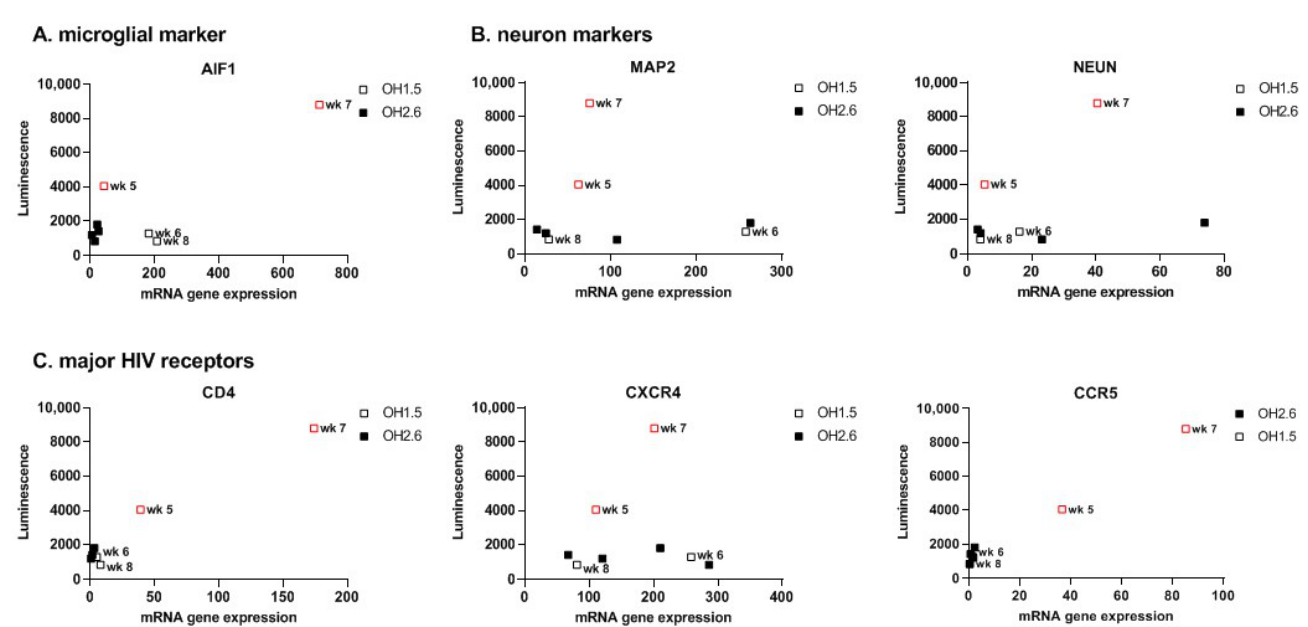
Figure 7. mRNA expression levels of microglia and neuron markers and HIV receptors in 3D Organoids. ( A ) Microglia and ( B ) neuron markers and ( C ) HIV receptor expression levels were assessed by qRT-PCR and plotted against the highest luminescence value of corresponding 3D organoid. Red squares depict 3D organoids with continued luminescence release. Cerebral organoids were derived from iPSC line OH1.5 and OH2.6. Gene expression was normalized to the reference gene ACTB.